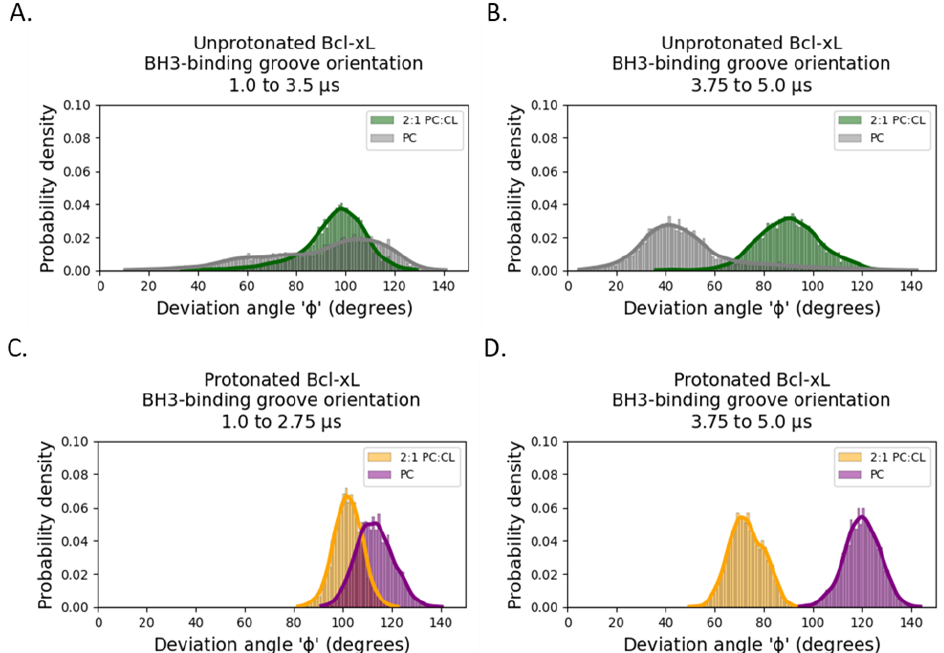
Figure 3. Orientational configurations of the BH3-binding groove. The changes in the distributions of the BH3-binding groove deviation angle from the membrane normal over two separate time intervals indicate that the presence of cardiolipin narrows the configurational space sampled by the soluble head and that both protonation of Bcl-xL and cardiolipin favors orientations of the soluble head, consistent with accessible configurations of the BH3-binding groove. ( A , B ) Binding-groove deviation angle distributions for unprotonated simulations based on stationary portions of unprotonated PC system. ( C , D ) Binding groove deviation angle distributions for protonated simulations based on stationary portions of protonated 2:1 PC:CL system. All angle histograms are colored as in Figure 2C, D.